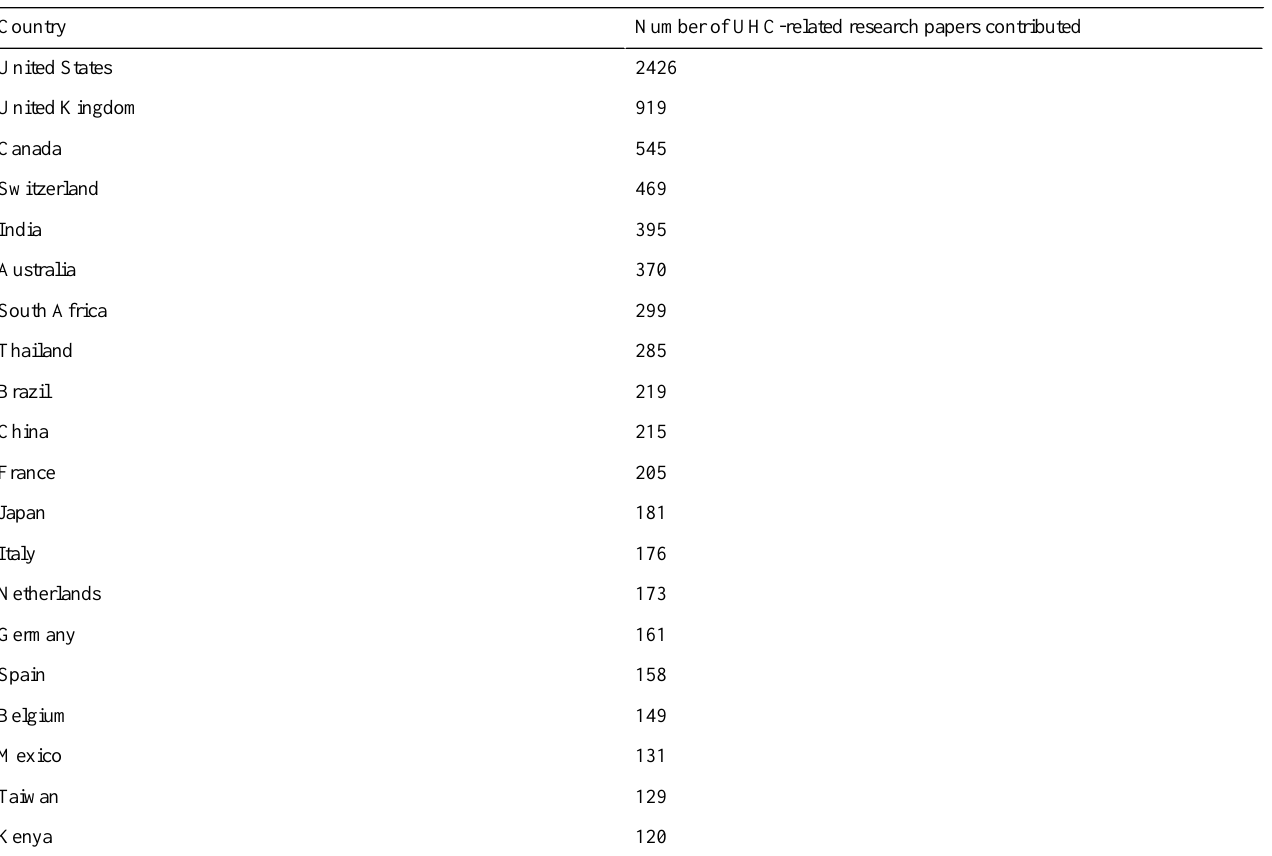
Table 6. Countries and regions that contributed the most to the research field of universal health coverage (UHC) during 1990-2019. Number of UHC-related research papers contributedCountry